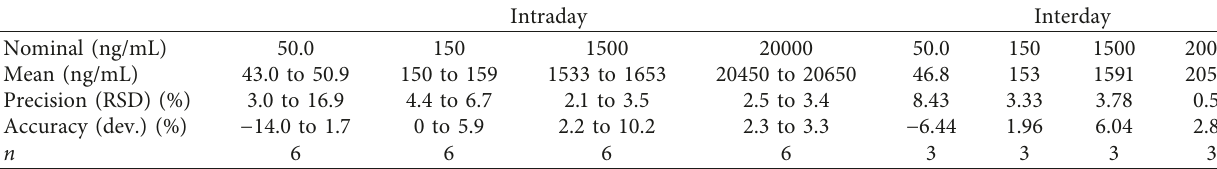
Table 2: Intra- and interday precision and accuracy.